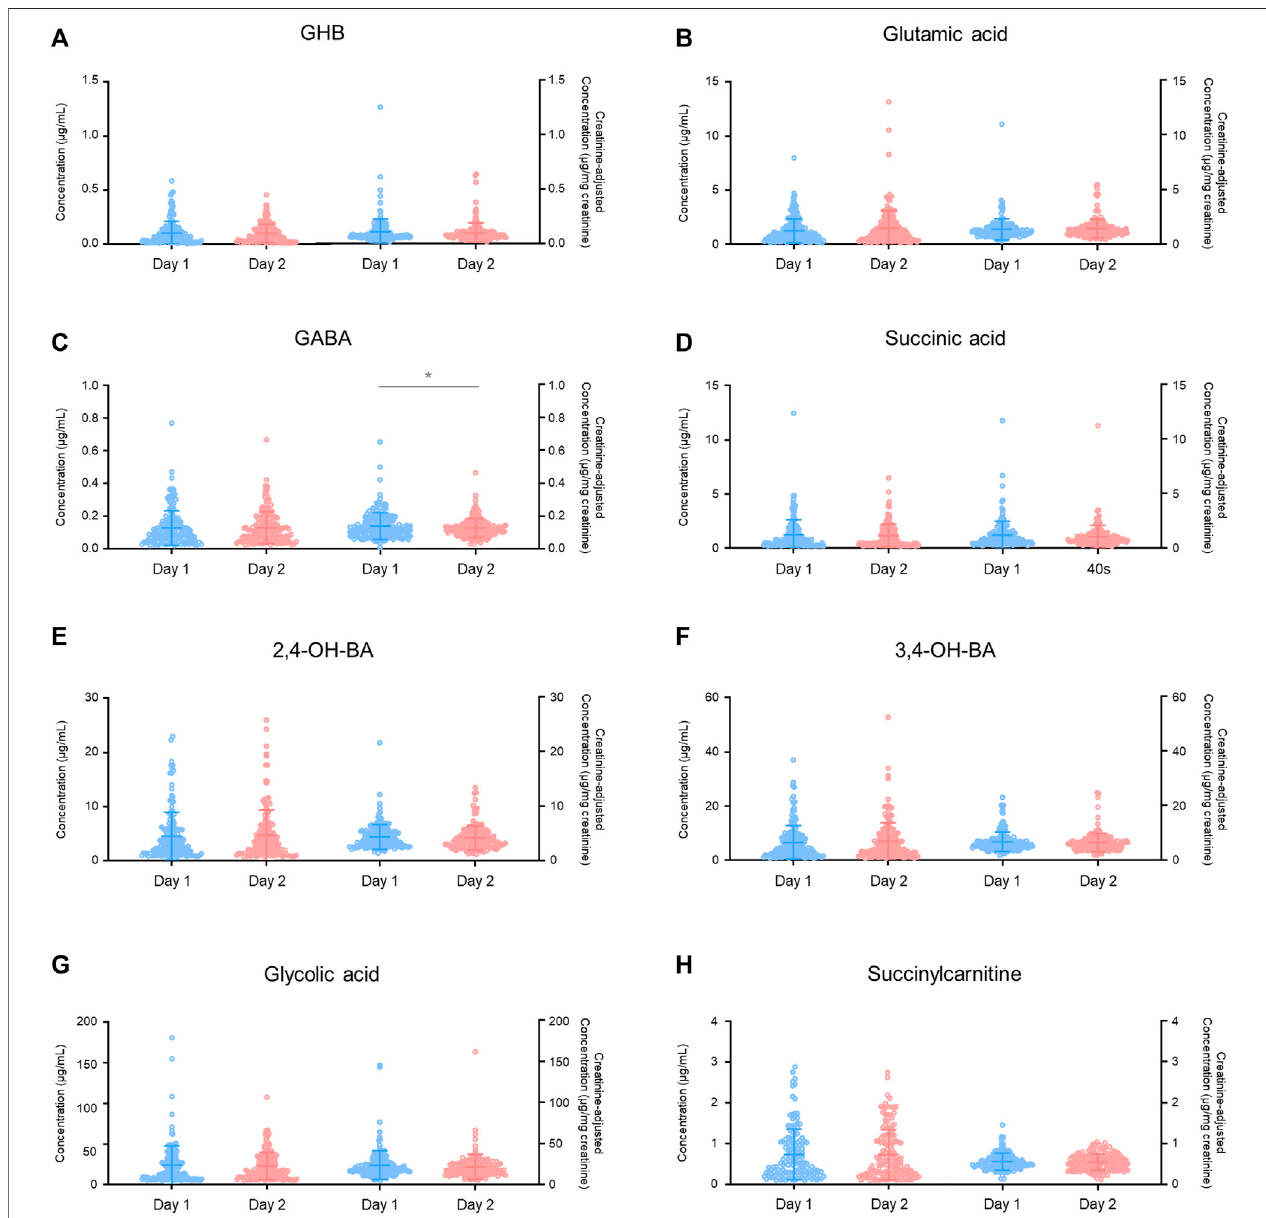
FIGURE4| Inter-day variabilitiesinunadjustedandcreatinine-adjustedconcentrationsofGHB (A) ,glutamicacid (B) ,GABA (C) ,succinicacid (D) ,2,4-OH-BA (E) , 3,4-OH-BA (F) , glycolic acid (G) , and succinylcarnitine (H) . Horizontal lines within the scattered dots indicate means ± standard deviations. Values less than the limit of quanti fi cation were excluded. * p <